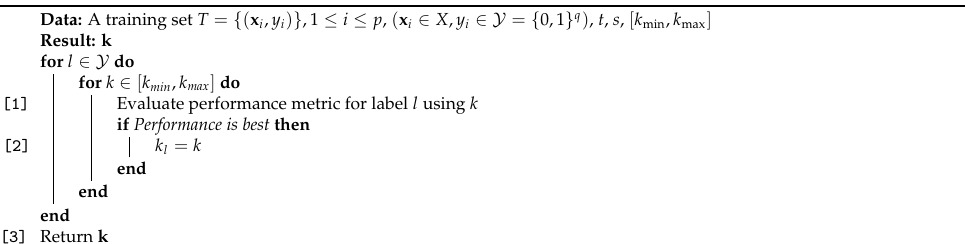
Algorithm 3: ML-k’sNN.ML: Multi-label k’s nearest neighbors algorithm multi- label